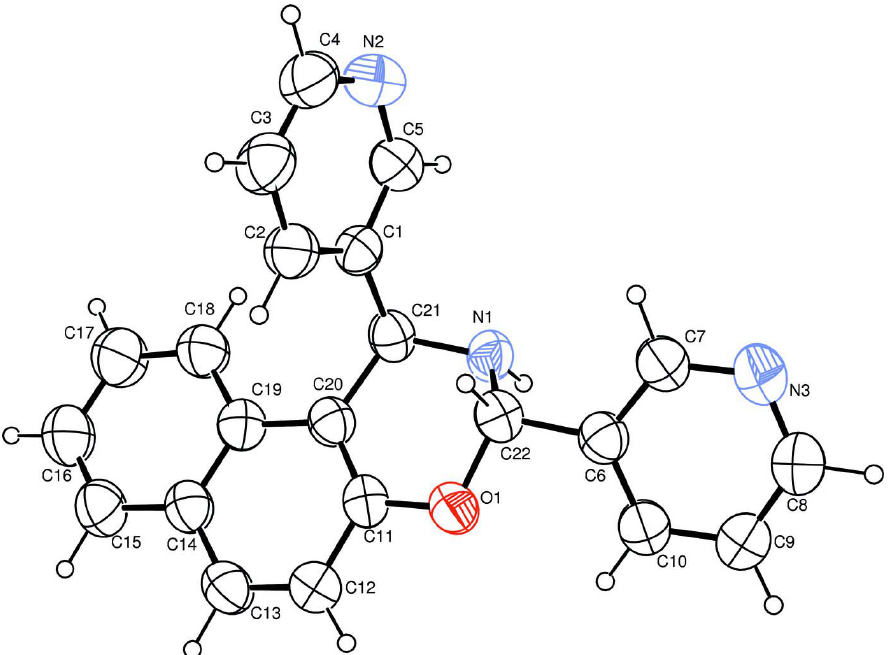
An ORTEPIII (Burnett & Johnson, 1996) view of the title compound with the atomic numbering scheme. Displacement ellipsoids are drawn at the 50% probability level. H atoms are shown as spheres of arbitrary